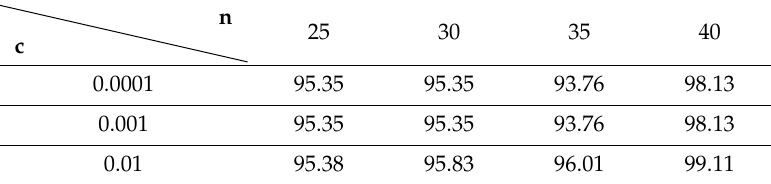
Table 2. Local outlier factor (LOF) parameter choosing result (MS).